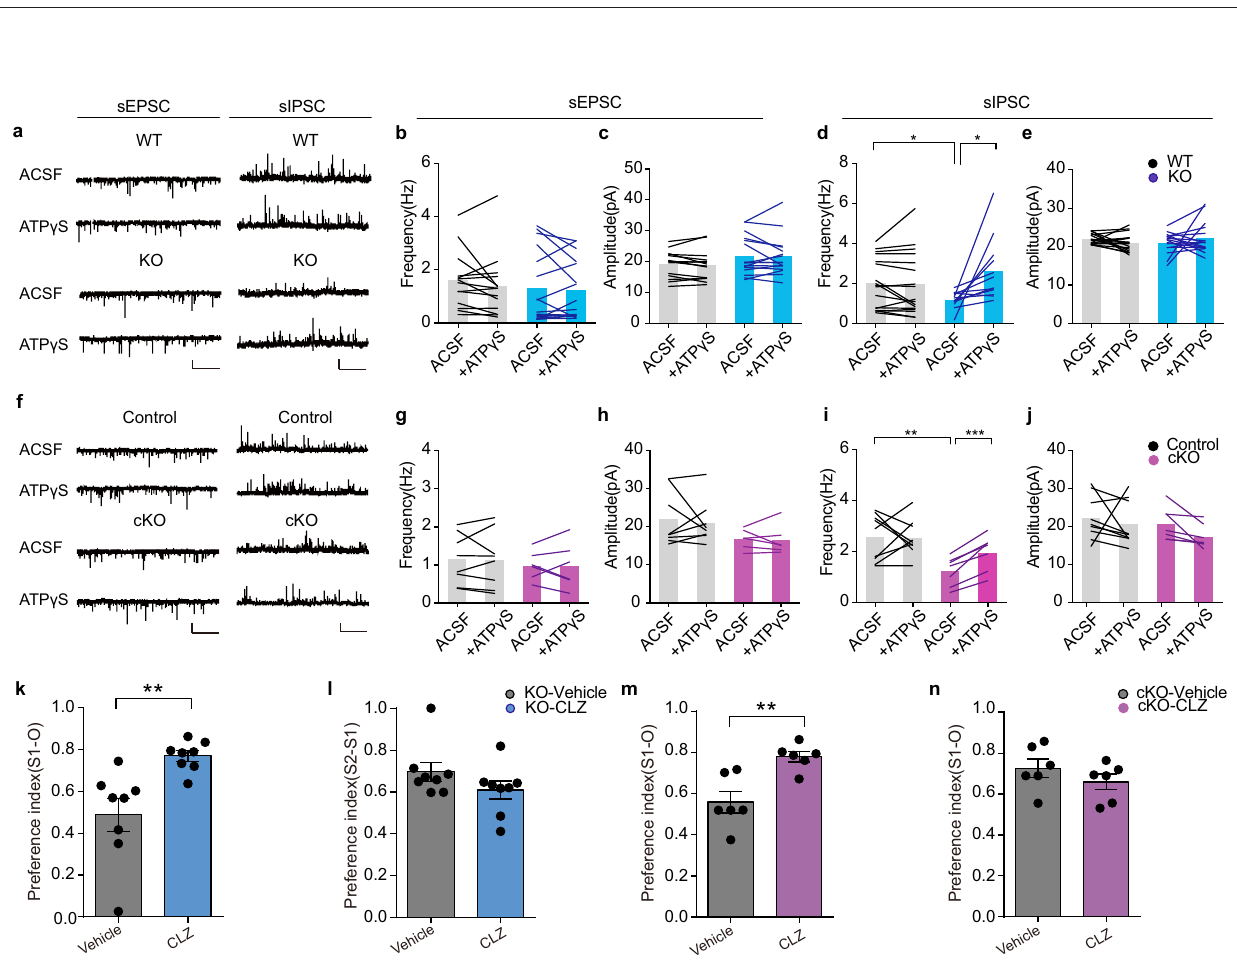
Fig. 4 IP3R2 mutant mice exhibit impaired GABAergic neurotransmission, which can be restored by ATP γ S treatment. a sEPSC and sIPSC recordings with and without ATP γ S (25 µ M) treatment in mPFC layer 5 pyramidal neurons from WT and IP3R2 KO slices. Scale bars: 20 pA, 2 s. b – e Bar graphs showing sEPSC and sIPSC frequency ( b , d : WT ACSF vs . KO ACSF , two-tailed unpaired t -test, t 27 = 2.173, P = 0.0387, n = 17/12; WT ACSF vs . WT ATP γ S , two- tailed paired t -test, t 16 = 0.3945, P = 0.6984, n = 17; KO ACSF vs . KO ATP γ S , two-tailed paired t -test, t 11 = 2.905, P = 0.0143, n = 12) and amplitude ( c , e ) in WT and IP3R2 KO slices with and without ATP γ S treatment. IP3R2 KO mice exhibited impaired GABAergic neurotransmission that was restored by ATP γ S treatment. f Same as ( a ) but for IP3R2 cKO slices. Scale bars: 20 pA, 2 s. g – j Bar graphs showing sEPSC and sIPSC frequency ( g , i control ACSF vs . cKO ACSF , two-tailed unpaired t -test, t 14 = 3.163, P = 0.0069, n = 7/9; control ACSF vs. control ATP γ s , two-tailed paired t -test, t 8 = 0.1744, P = 0. 8659, n = 9; cKO ACSF vs. cKO ATP γ s , two-tailed paired t -test, t = 6.462, P = 0.0007, n = 7) and amplitude ( h , j ) in control and IP3R2 cKO slices. k , l Rescue of social behaviors in 6 IP3R2 KO mice upon acute clonazepam (CLZ, 0.0625 mg/kg, i.p.) treatment in the three-chamber test ( k U = 3, P = 0.0011; l t 14 = 1.399, P = 0.1836, n = 8). m , n Same as ( k , l ) but for IP3R2 cKO mice ( m t = 3.757, P = 0.0037; n t = 1.153, P = 0.2758, n = 6). Each data point represents an individual 10 10 mouse ( k – n ). Data are presented as the mean ± SEM. Two-tailed unpaired t test ( l – n ). Mann – Whitney U-test ( k ). * P < 0.05, ** P < 0.01, *** P <